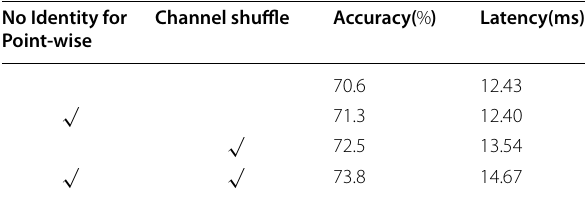
Table 8 Ablation Study for Identity and Channel